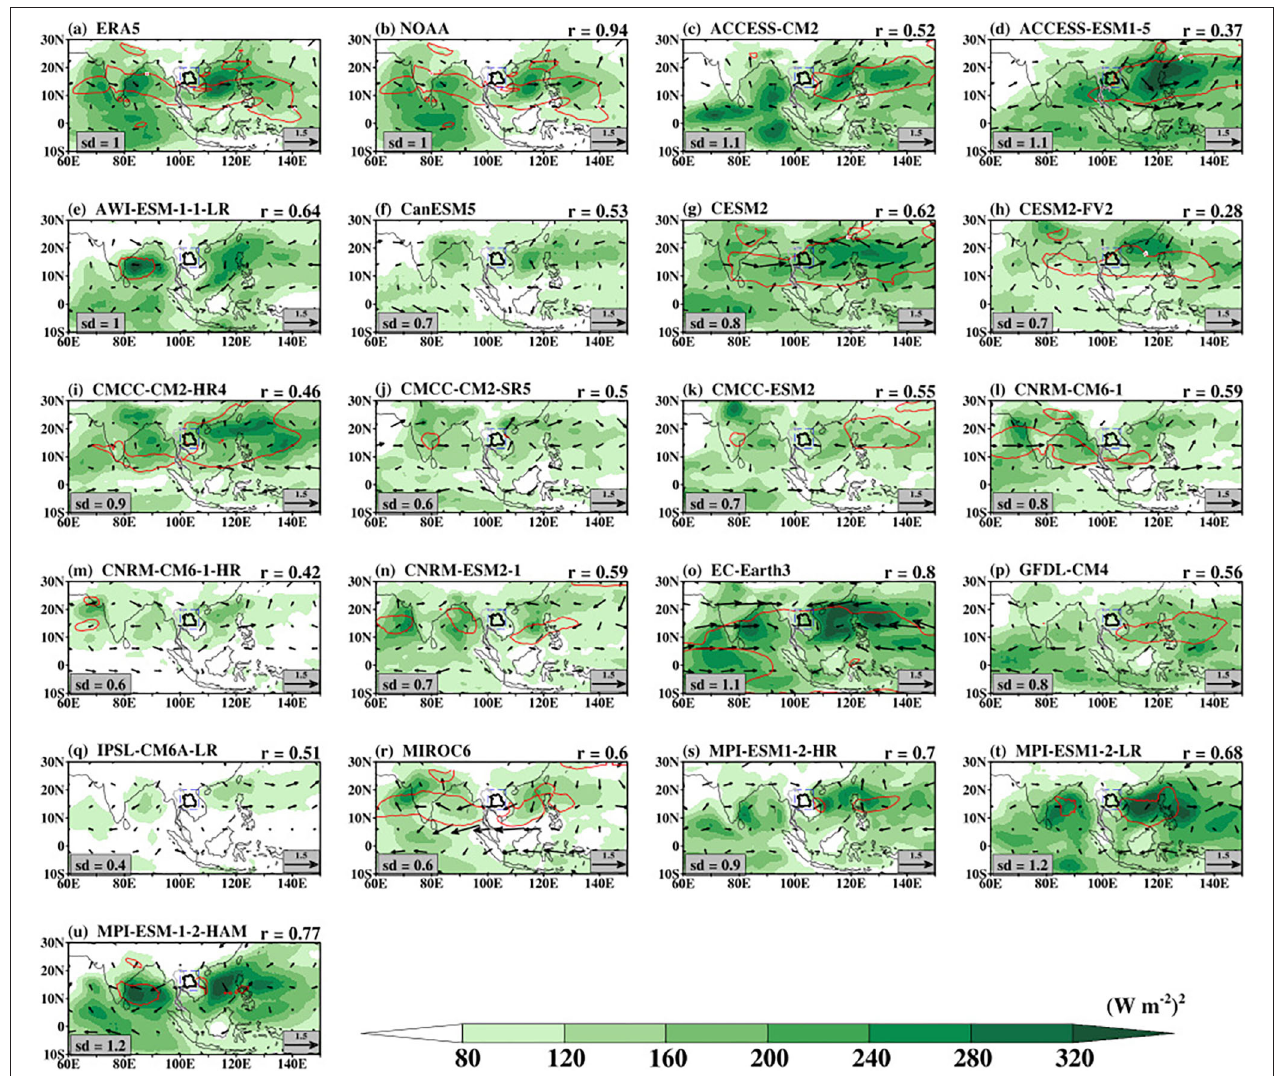
FIGURE 2 | Variance of 30–60-day bandpass-filtered intraseasonal OLR and 850-hPa zonal wind (contour) overlaid with 30–60-day bandpass-filtered 850-hPa wind (vector) anomalies during the boreal summer (May–October) obtained from observations and CMIP6 models for the period 1997–2014. The solid red contour is the 4.0 (m s − 2 ) 2 isoline of the bandpass-filtered 850-hPa zonal wind variance. The Spearman correlation (r) of filtered OLR anomaly on ( b ; NOAA) and ( c–u ; CMIP6 models) is obtained against (a) ERA5 as the reference. The standard deviation of OLR normalized by the ERA5 standard deviation is shown at the bottom left of the plot.